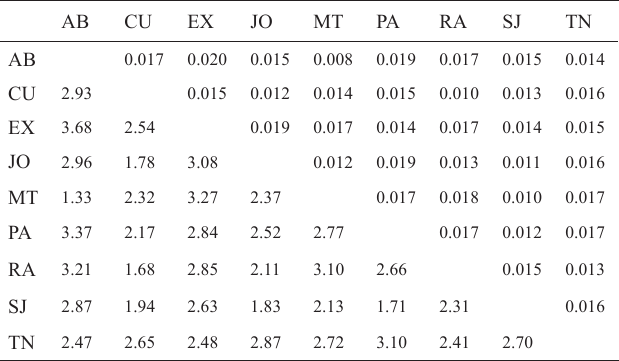
Table 2 . Mahalanobis distances (lower half of the matrix) and Procrustes distance (upper half of the matrix) among populations calculated from the canonical correlation analysis. Sites: AB: Água